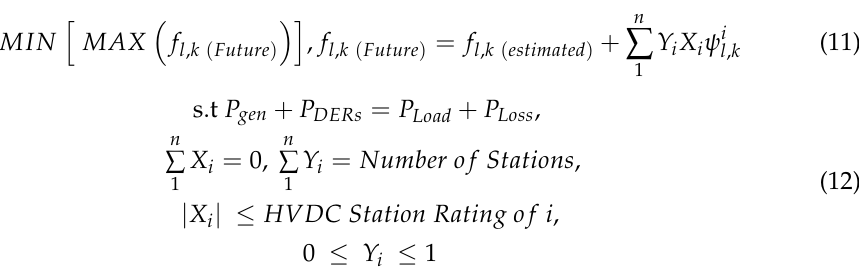
Figure 3. Proposed methodology conduct procedure.